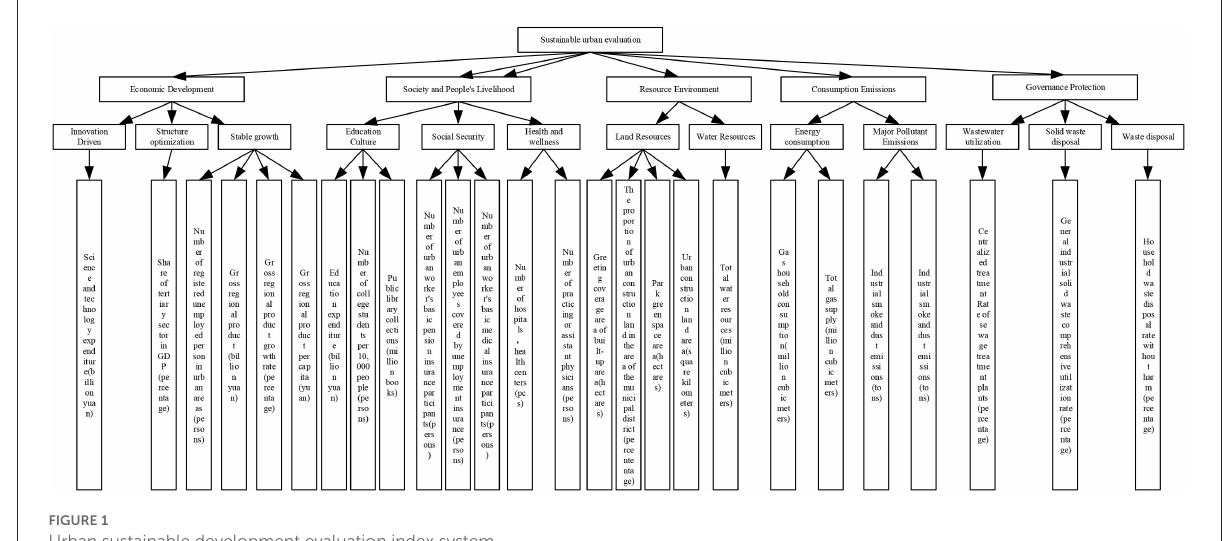
FIGURE1 Urban sustainable development evaluation index